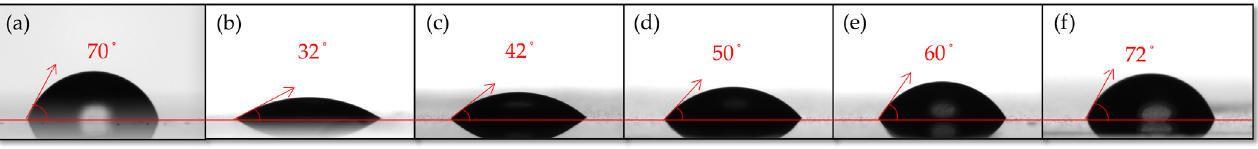
Figure 2. Representative images of the variations in the water contact angles for the PET samples: ( a ) untreated and ( b ) treated with 7.5 kW at 4 m/min. Samples ( c – f ) show the WCA variations for sample ( b ) after ( c ) 1 week ageing, ( d ) 2 weeks ageing, ( e ) 3 weeks ageing and ( f ) after washing.